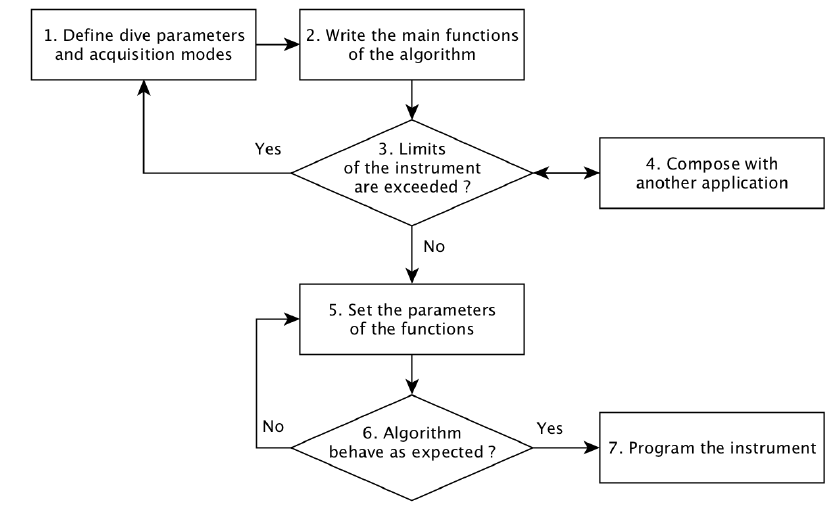
Figure 7. Development workflow with